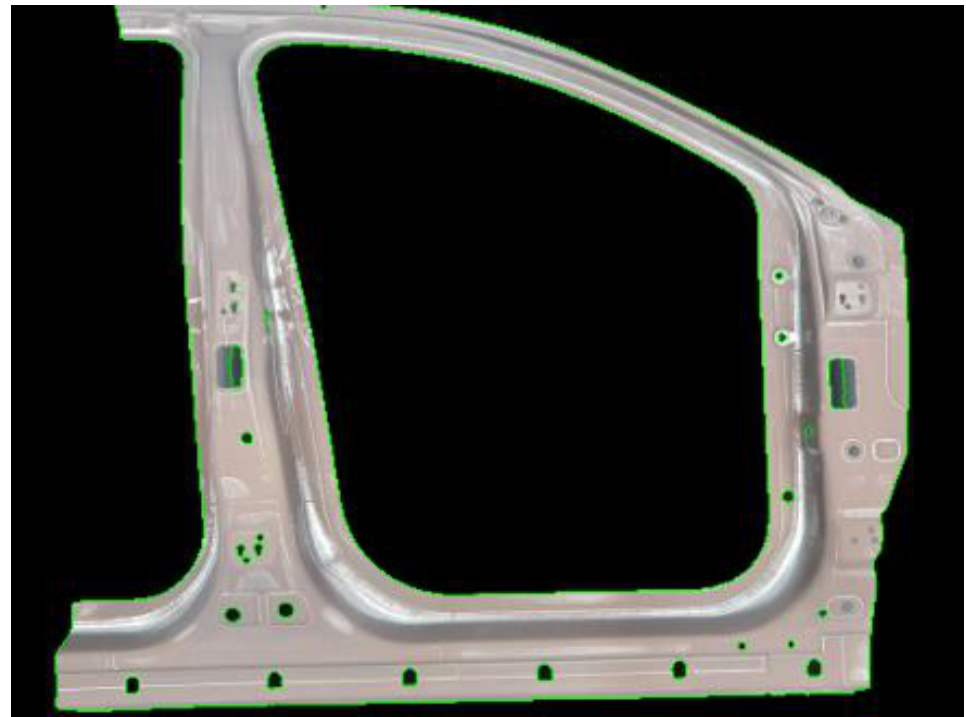
Figure 4. Pre-processed data: background elimination and contouring.